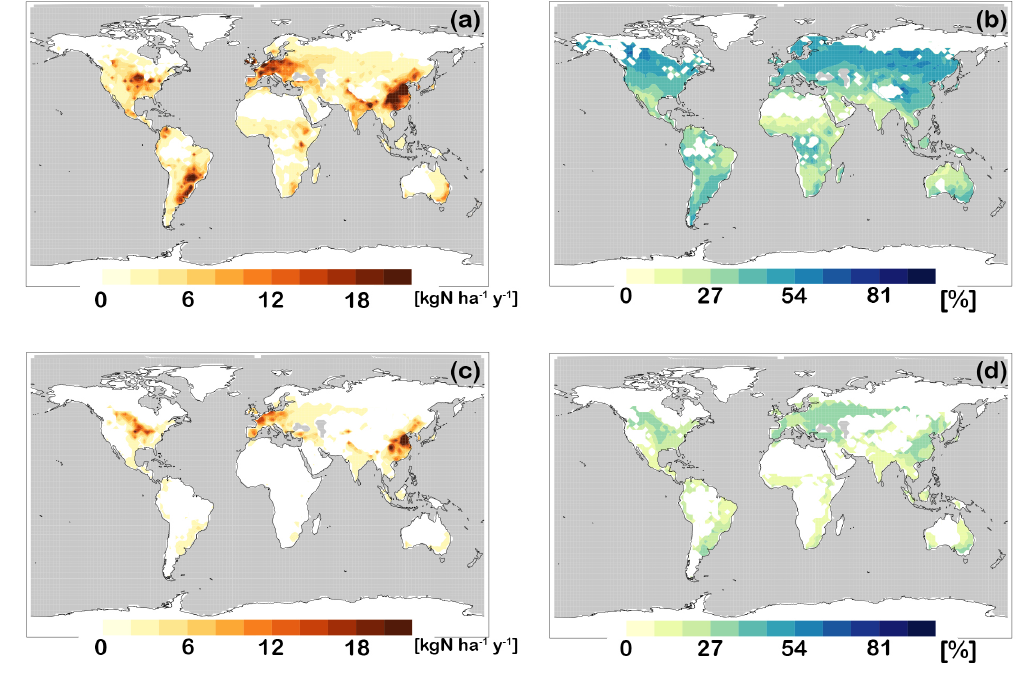
Figure 7. As in Fig. 6 but for simulated nitrification.